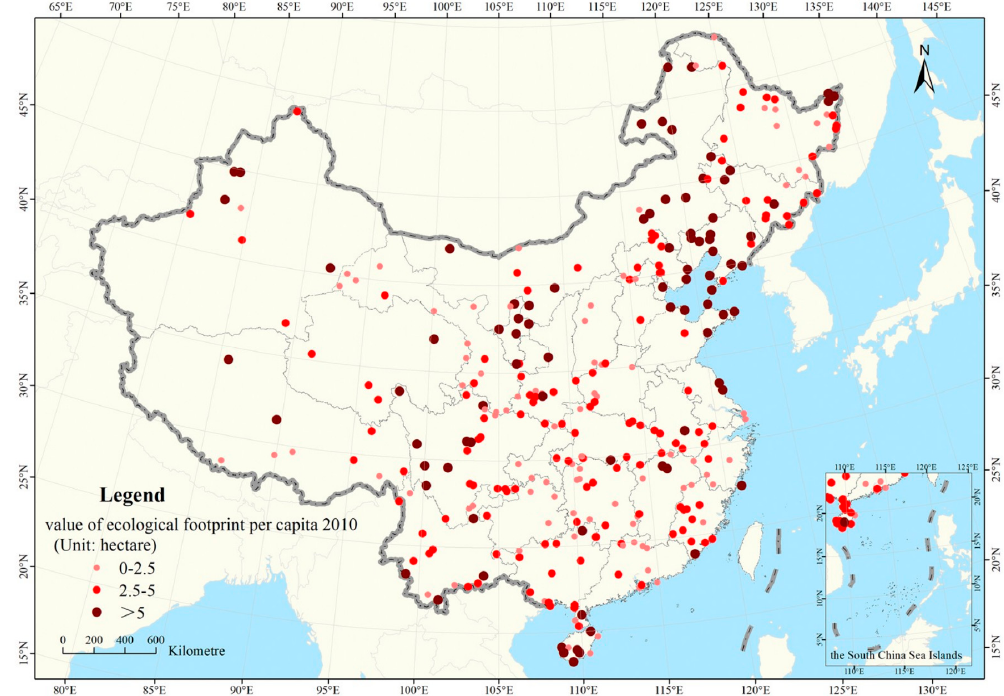
Figure 3. Spatial distribution of average ecological footprint in National Nature Reserves in 2010 [60].